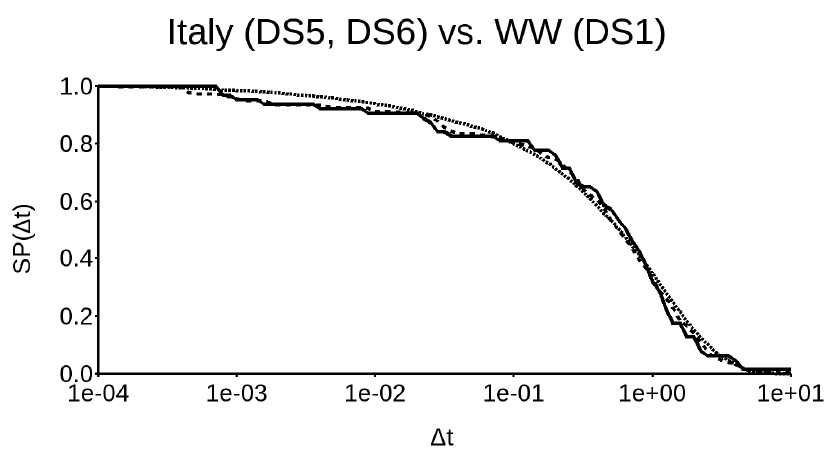
Figure 8. Survival probability relative to DS1, DS5, and DS6. The solid line refers to DS5, the dashed line refers to DS6, and the dotted line refers to DS1.